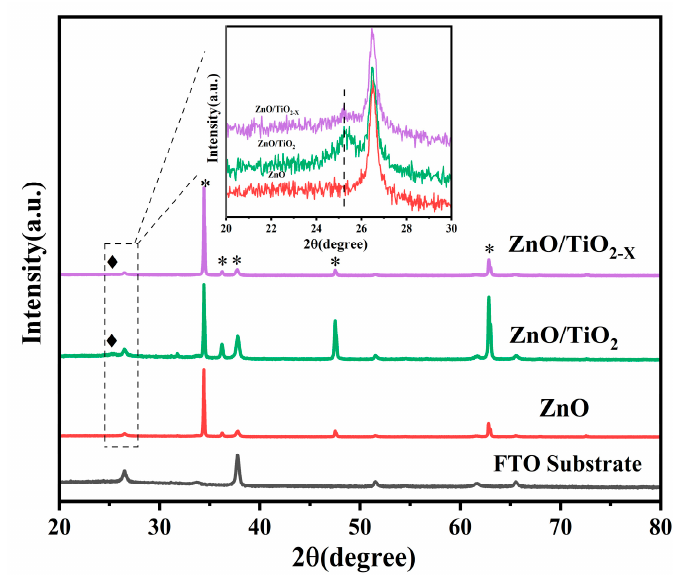
Figure 3. XRD patterns of ZnO, ZnO/TiO 2 , ZnO/TiO 2-X , and FTO substrate samples (* represents the peak position of the hexagonal ZnO with a wurtzite structure and ♦ the peak position of TiO 2 anatase phase).